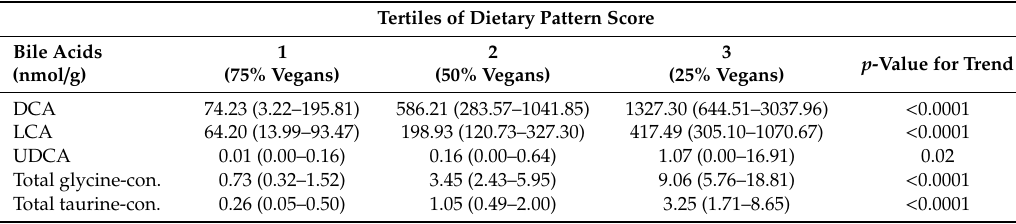
Table 2. Concentrations of fecal bile acids across first pattern score. Tertiles of Dietary Pattern